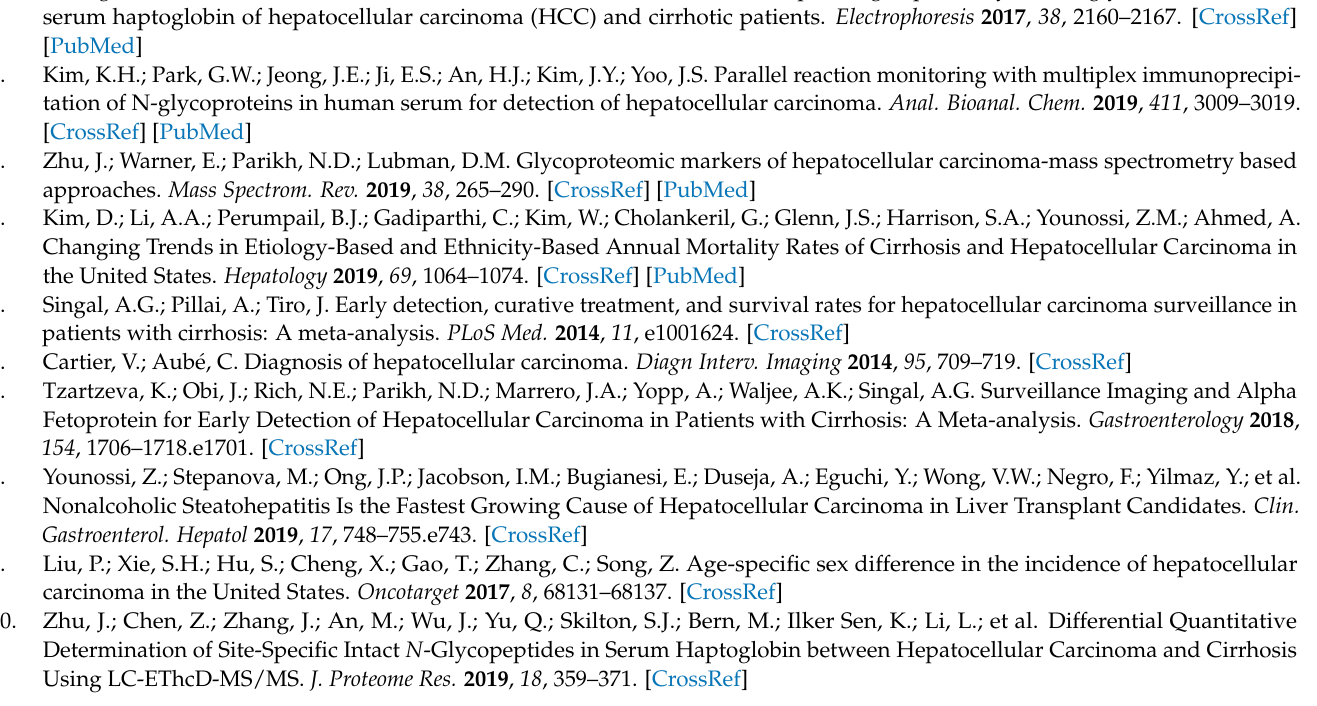
cohorts, Table S6: statistical comparison between gender groups, and Table S7: determination of haptoglobin N -glycopeptides with significative changes in abundance between cirrhosis and early HCC, using same gender ratio female:male in both sample